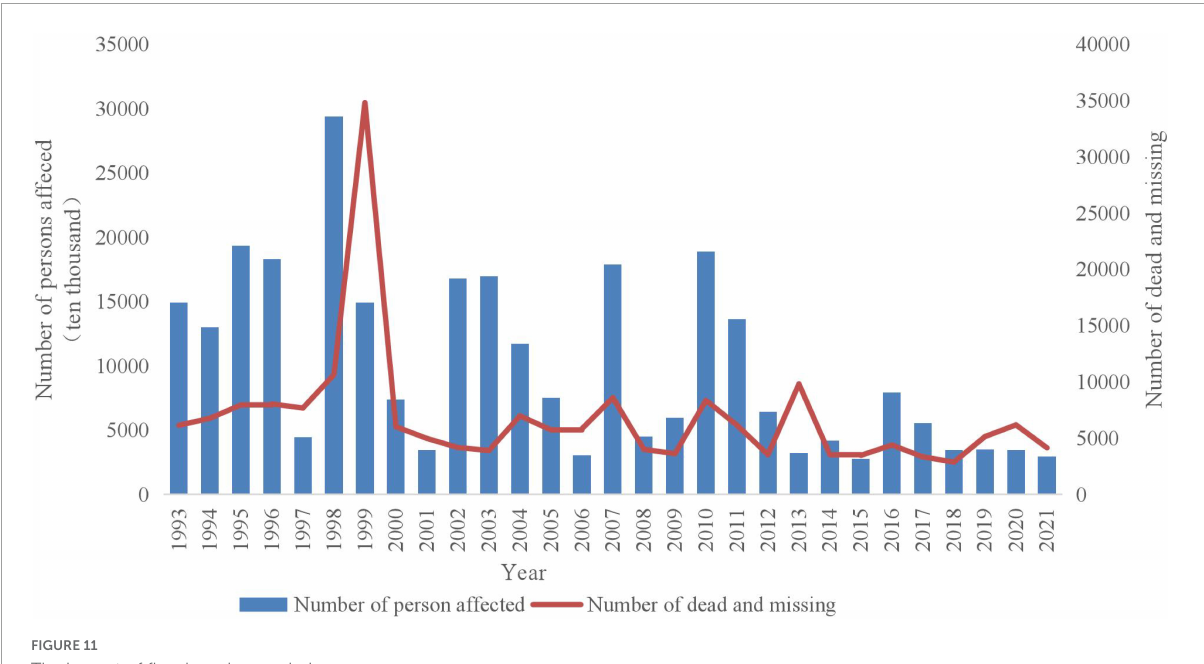
FIGURE11 The impact of floods on human beings.